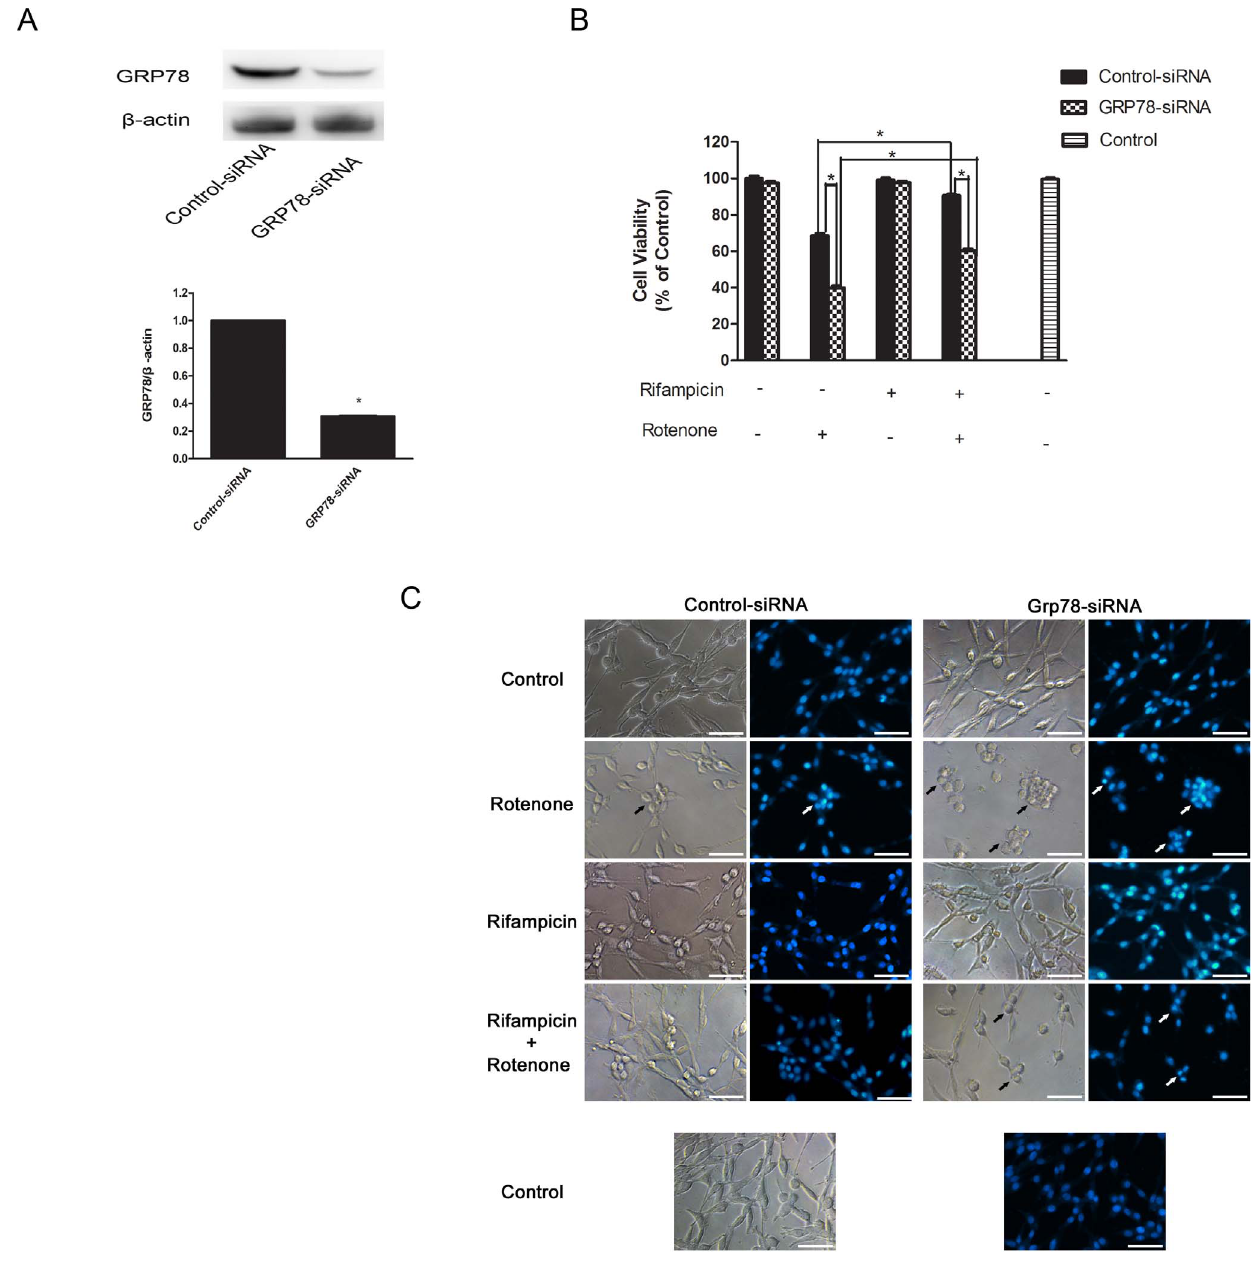
Figure 3. Rifampicin-induced neuroprotection was GRP78-dependent. PC12 cells were transfected with GRP78-specific siRNAs or control siRNAs for 24 h. After that, cells were treated with or without 150 m M rifampicin for 2 h, followed by 1 m M rotenone for 24 h. (A) Western blot analysis verified the efficient gene silencing of GRP78. (B) After the above treatment, cell viability was measured and presented as the relative viability (% control). (C) Morphological evaluation of PC12 cells under the above-mentioned treatment by light microscopic observation and DAPI staining. The apoptotic cells were marked with arrows. Scale bar=25 m m. (B–C) GRP78 gene silencing significantly exacerbated rotenone-triggered neuron injury, with or without the presence of rifampicin. Neither GRP78-specific nor control siRNAs decreased cell viability. Data present mean 6 SEM of three independent experiments. *p , 0.05.